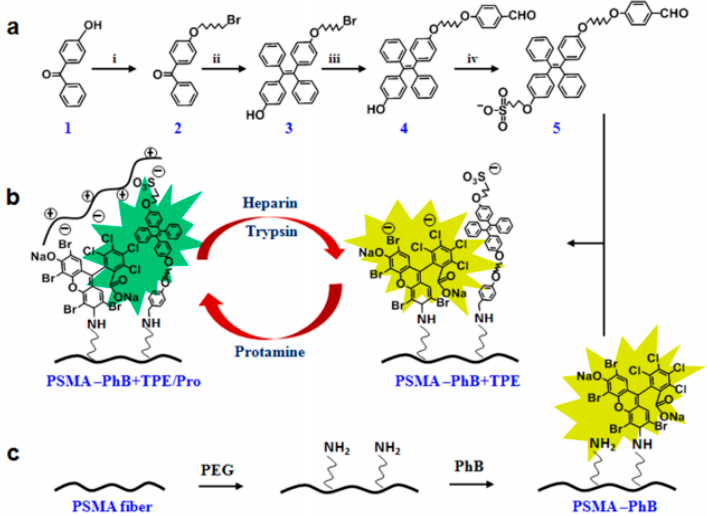
Figure 9. Synthetic rout of TPE and the principles of the change of color for electrospun PSMA fliers: ( a ) Synthetic route of TPE, ( b ) schematic of color changing process due to protamine adsorption and interaction of TPE and PhB, and ( c ) formation of the grafted PhB on fibers [157]. Reprinted from the ACS Applied Materials and Interfaces, Vol. 9, Long Zhao, Tao Wang, Qiang Wu, Yuan Liu, Zhoujiang Chen, and Xiaohong Li, Fluorescent Strips of Electrospun Fibers for Ratiometric Sensing of Serum Heparin and Urine Trypsin, 3400–3410., Copyright (2018) with permission from ACS. With Cu 2+ ions generated in an array of biological reactions, the efficient and effective detection of these particles is desired. Nitrogen-doped carbon dots can be used to identify label-free Cu 2+ fluorescent through fluorescent sensing.